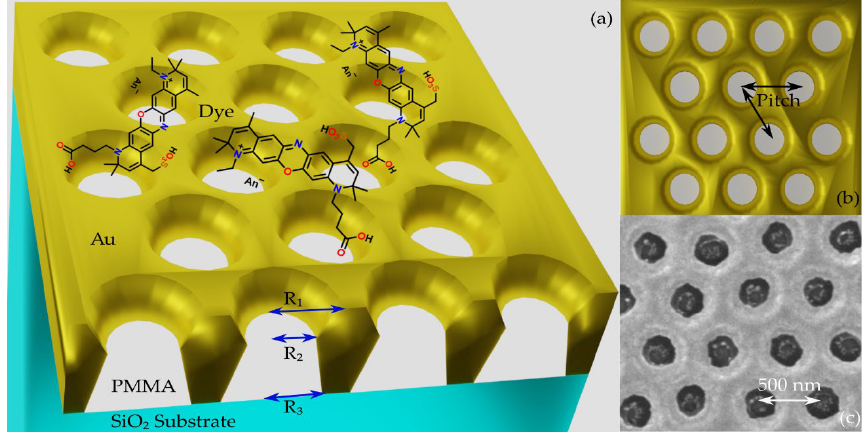
Figure 1. Structure of the platform under investigation: ( a ) outline of the stack showing the plasmonic metasurface, PMMA/air nanopillars in a gold layer, functionalized to deposit ATTO700 dye. The interface of the structure with the SiO 2 substrate is referred as the back side (BS) of the structure, while the gold/PMMA/air interface as the front side (FS); ( b ) top-view of the plasmonic metasurface geometrical features determining the optical response. In our plasmonic metasurface, the presence of both LSPs and SPPs over the same spectral interval enables their mutual coupling (hybrid plasmonic resonances). Their spectral position depends on the lattice pitch because the excitation of surface plasmons is provided by the surface periodicity. Further, the array pitch is responsible for the spectral tuning of the plasmonic resonance, whereas the radii mainly influence the plasmonic resonance shape. Consequently, these parameters determine the interaction volume to maximize the spectral overlap (coupling efficiency) between the plasmonic resonance (spectra) and the dye emission (spectra); ( c ) FS SEM image of the plasmonic metasurface. The arrows indicate the dimensions of the geometrical parameters and morphological